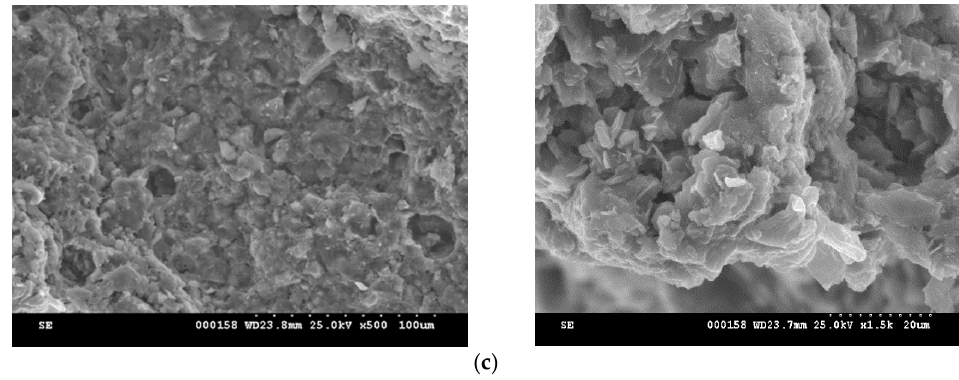
Figure 9. SEM images of MTA2 pastes hydrated for: ( a )—1 day; ( b )—7 days; ( c )—28 days.